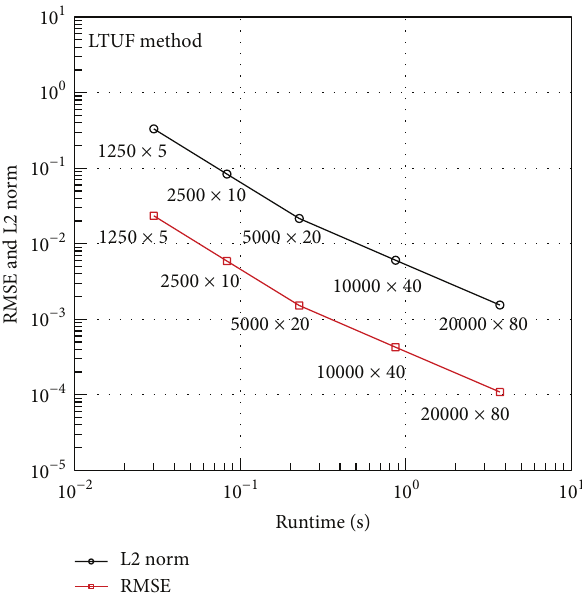
Figure 5: Comparison of RMSE and L2 norm with LTUF method in the solution.